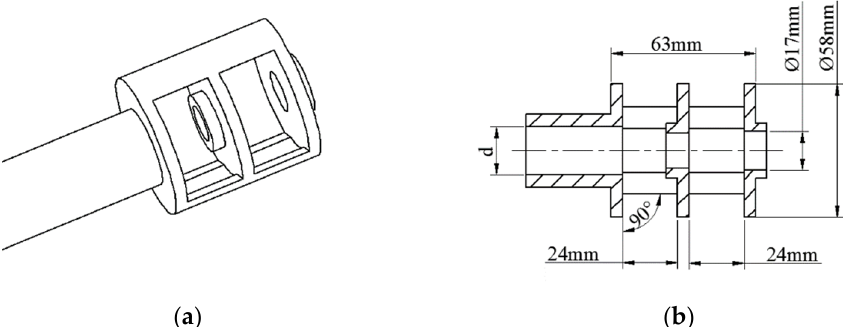
Figure 2. Schematic diagram of muzzle brake. ( a ) 3D view. ( b ) Top view (section).